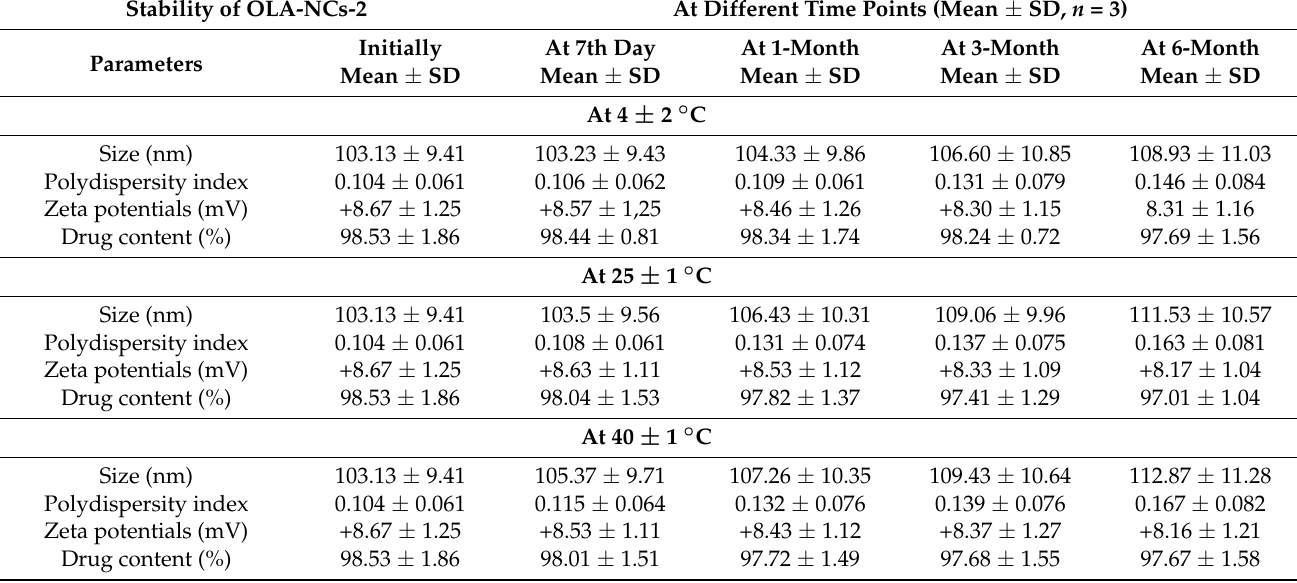
Table 4. Stability results of freeze-dried OLA-NCs-2. The data are the mean of three measurements with standard deviation (Mean ± SD, n = 3).